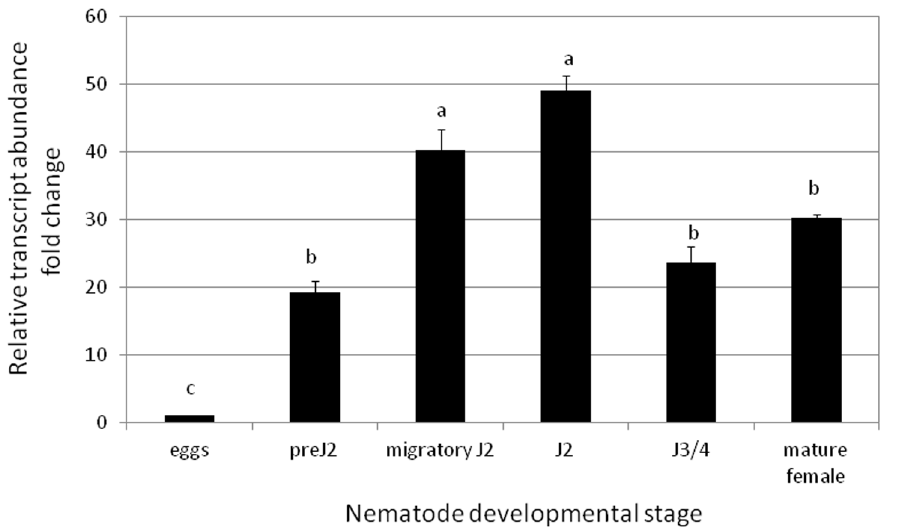
Figure 2. Kinetics of mj-far -1 gene transcripts through M.javanica life cycle stages. mj-far-1 expression was detected for non-parasitic stages: eggs and pre-parasitic infective juvenile J2s; and within tomato roots, for migratory parasitic J2s (6 h and 48 h after infection), J2s and J3/J4 juveniles, and mature females (15 and 28 DAI, respectively). mj-far - 1 transcripts were normalized using the normalisation factor calculated as the geometric mean of the expression levels of two most stable nematode endogenous reference genes, 18S and EF-1 a . Each reaction was performed in triplicate and the results represented the mean of two independent biological replicates. Data represent the mean relative expression and standard error obtained from two independent biological experiments. Different letters above the bars denote a significant difference ( P # 0.05, analysis of variance) between samples as analyzed by Tukey-Kramer multiple comparison test. The experiment was repeated three times and similar results were